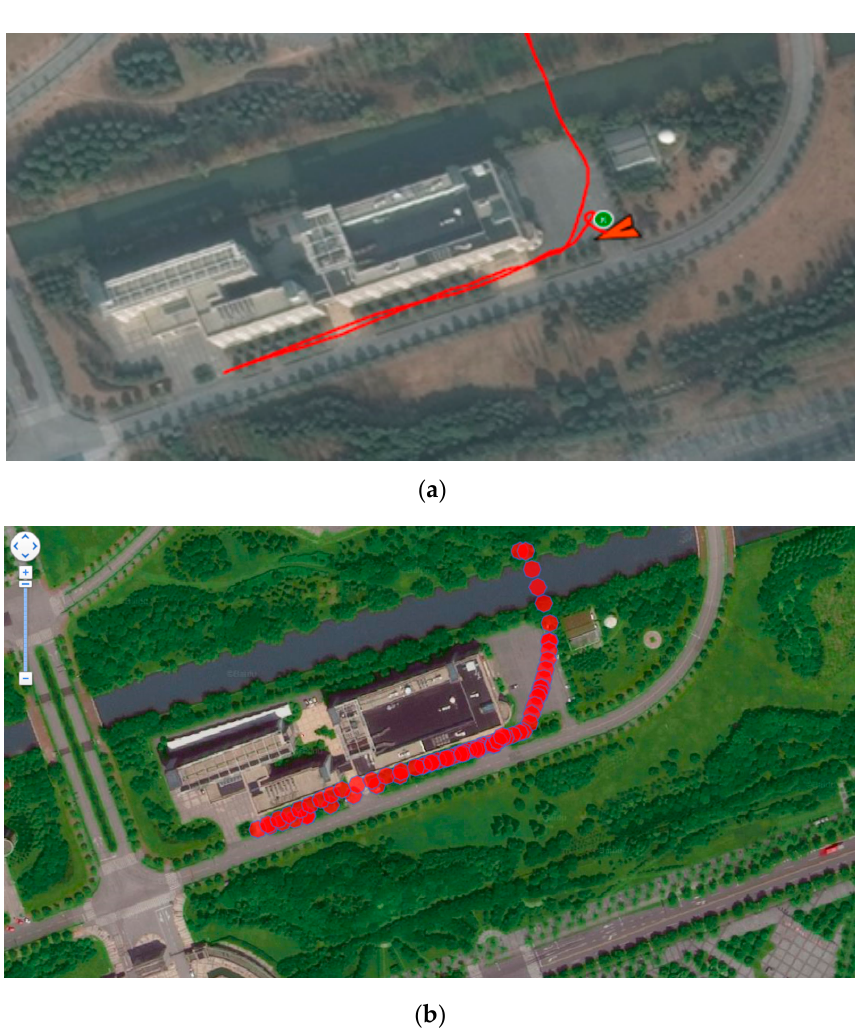
Figure 20. Unmanned Aerial Vehicle (UAV) trajectory verification. ( a ) Flight trajectory with software on the UAV; ( b ) Flight trajectory from ADS-B signal.